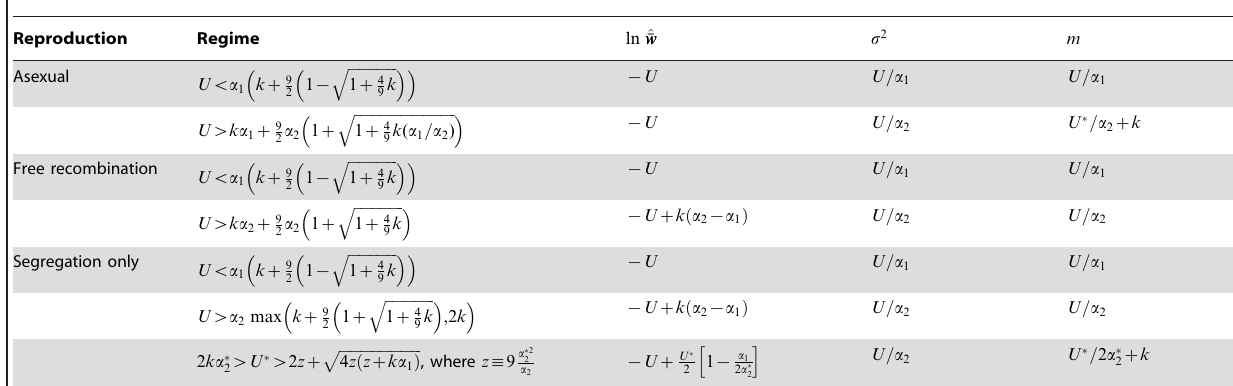
Table 2. Hidden epistasis when b ~ 0 .